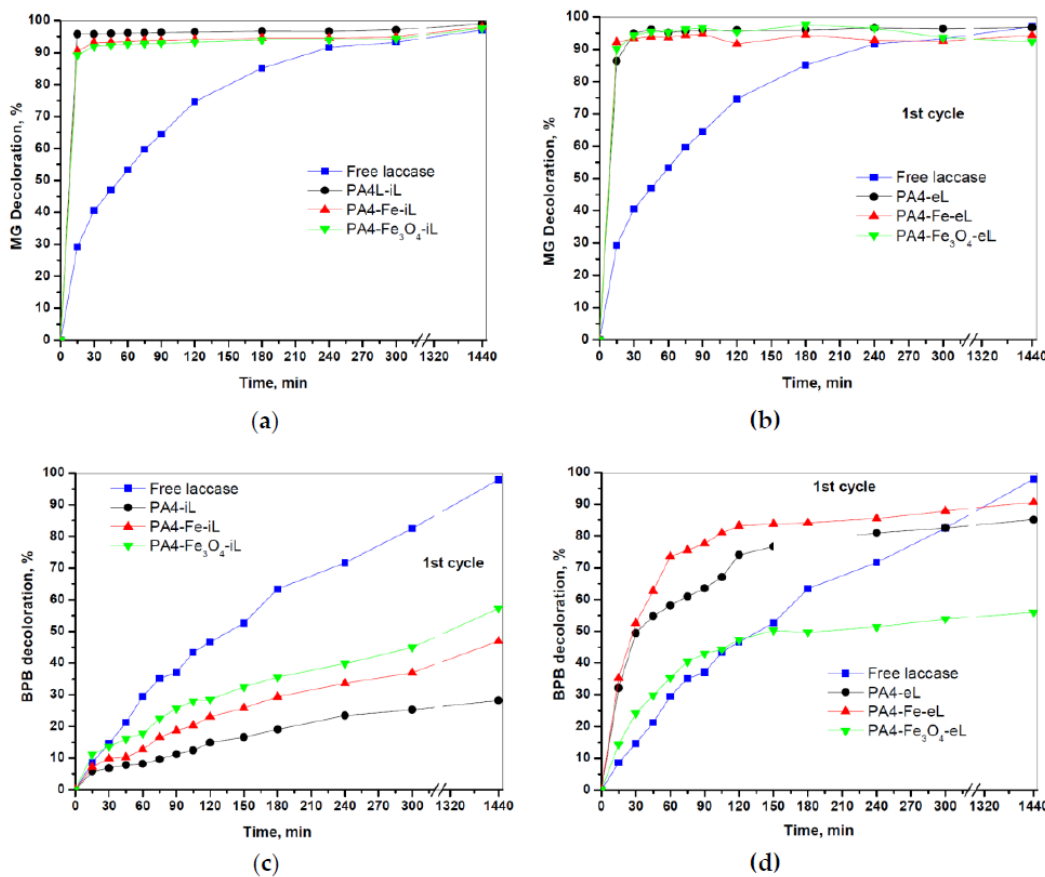
Figure 11. Decolorization of: ( a , b )—malachite green (MG) and ( c , d )—bromophenol blue (BPB) by PA4@iL or PA4@eL samples. The decolorization percentage was calculated according to Equation (5) (see Materials and Methods, Section